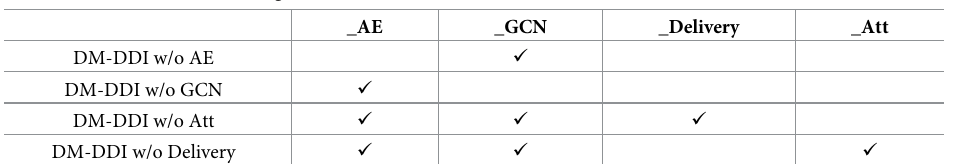
Table 4. Ablation variants